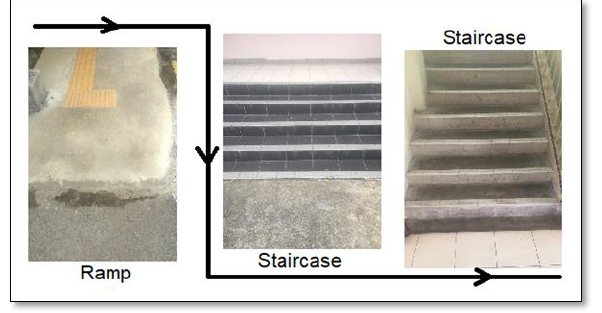
Figure 17. Testing Path 8.